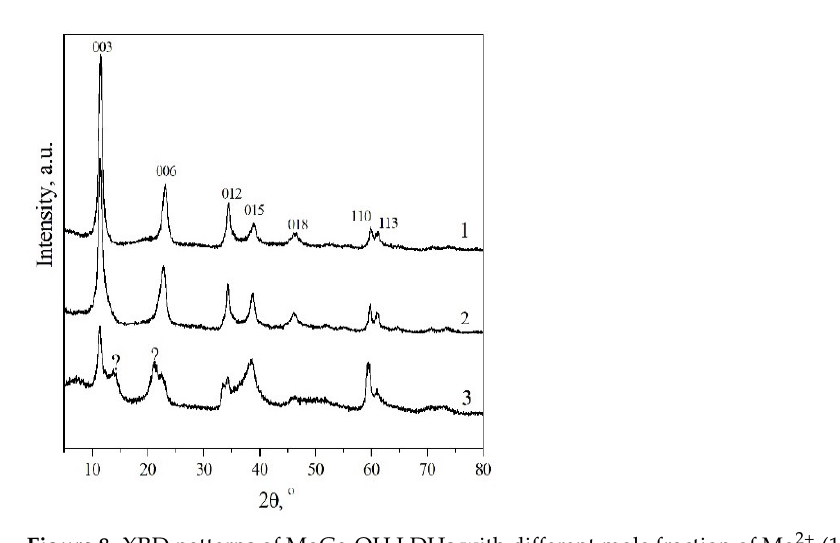
Figure 8. XRD patterns of MgGa-OH LDHs with different mole fraction of Mg 2+ (1)—0.67; (2)—0.75; (3)—0.80.